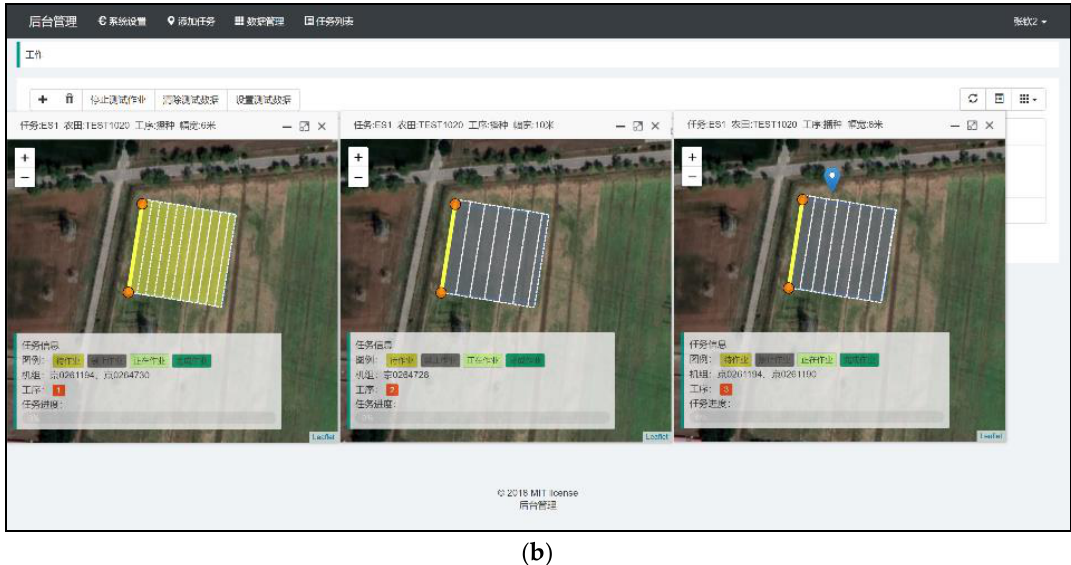
Figure 7. Part of the software interface of the auto-steering-based collaborative operating system for fleet management (FMCOS): ( a ) Software interface for farmland management and ( b ) Software interface for three-operation coordination.